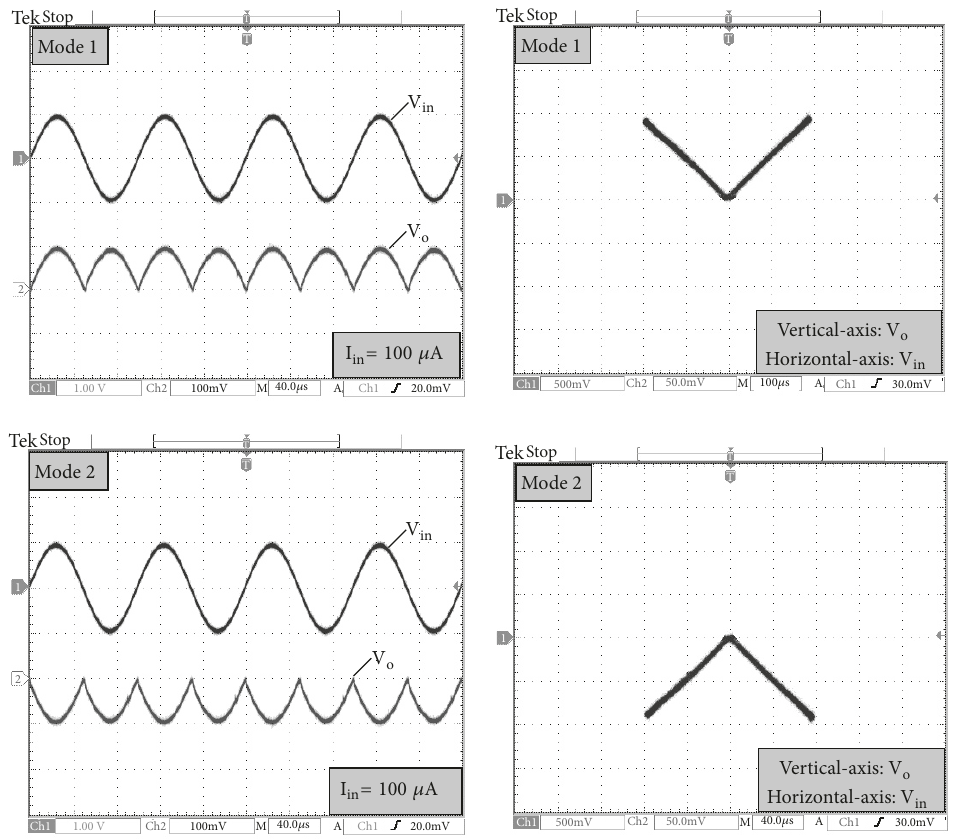
Figure 13: Experimental results of the input and rectified output waveforms and the corresponding input and output transfer characteristics of the circuit (Figure